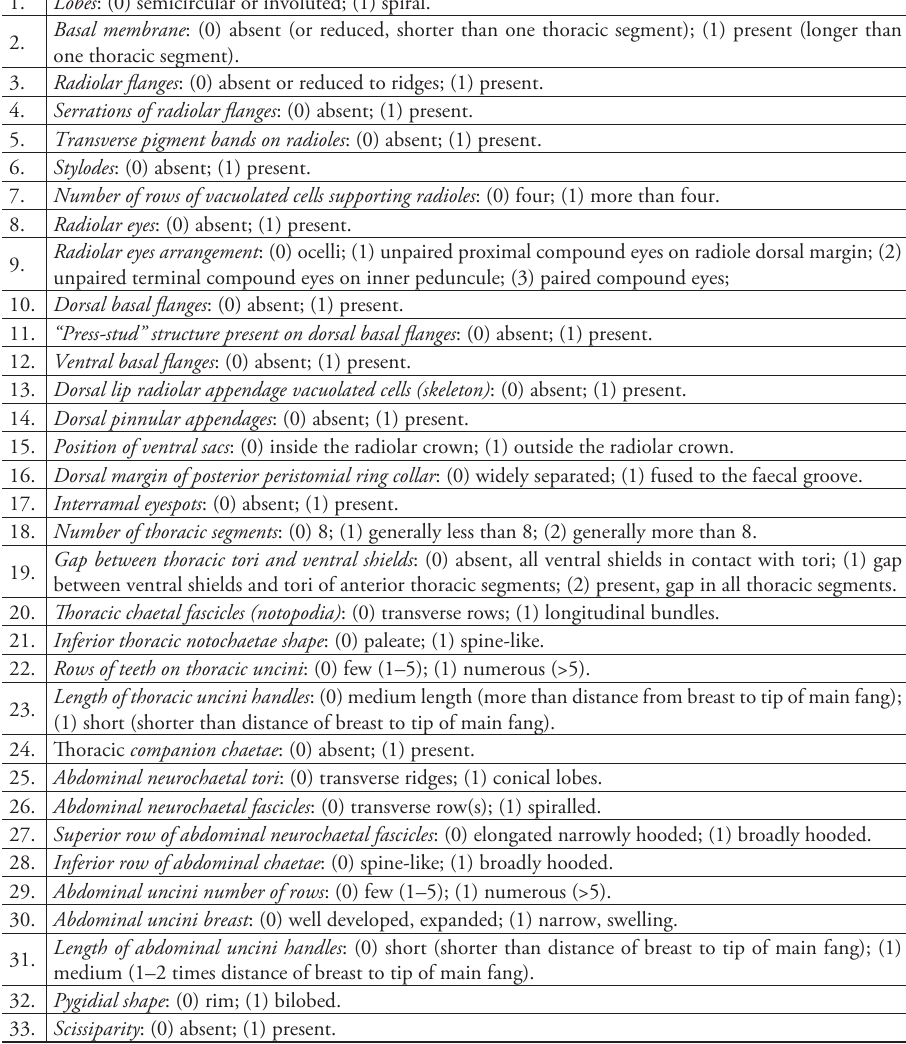
Table 2. Morphological characters and states scored in the matrix (Table 1). These are based on previ- ous cladistic analyses (e.g. Fitzhugh and Rouse 1999, Capa 2008, Capa et al. 2010), in addition to other features consider diagnostic for Pseudobranchiomma